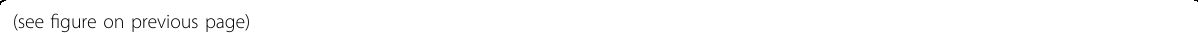
Fig. 1 Identi fi cation of GRP78 as a binding protein for the third intracellular loop of MC4R in the hypothalamus. Bacterially expressed GST alone and GST-MC4Ri3 proteins were incubated with mouse hypothalamic extracts. Pulldown complexes were separated by SDS-PAGE and visualized by silver staining ( a , upper gel). Coomassie blue staining shows immobilized GST alone or GST-MC4Ri3 proteins ( a, lower gel). An ~78-kDa band speci fi c to the GST-MC4Ri3 pulldown sample was isolated and sequenced by MALDI-TOF MS/MS analysis. b Amino acid (a.a.) sequence of GRP78. Peptide sequences obtained by MALDI-TOF MS/MS are indicated in red. c Schematic diagram of globular domains within Chinese hamster GRP78 (haGRP78); signal sequence (S: 1 – 18), nucleotide-binding domain (NBD: 19 – 407), substrate-binding domains (SBD β , 419 – 528 and SBD α , 529 – 654) with an ER retention signal KDEL motif (aa 651 – 654) and the fi ve globular domain fragments (a.a. 1 – 252, 253 – 502, 1 – 385, 386 – 502, 503 – 654). Domain fragments are represented as D1, D23, D12, D3, and D4, respectively. d His-tag pulldown of bacterially expressed and puri fi ed GRP78 domain fragments with 3xFlag-MC4R expressed in HEK 293T cells. MC4R was incubated with His-tagged proteins coupled to Ni-NTA agarose beads. e GST pulldown assay showing the interaction between GST-MC4Ri3 and the third globular domain of GRP78. To con fi rm the MC4R – GRP78 interaction in vitro, coimmunoprecipitation was performed using membrane proteins obtained from HEK 293T cells transfected with 3xFlag-MC4R or GRP78-Myc plasmids. f Membrane proteins were immunoprecipitated with anti-Flag and then immunoblotted with anti-Myc. g Membrane proteins were immunoprecipitated with anti-Myc and then immunoblotted with